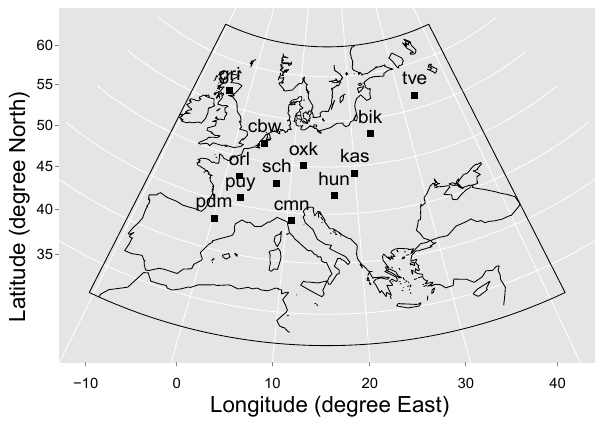
Fig. 1. Spatial domain of the WRF-VPRM simulations. Squares indicate the location of continuous CO 2 measurement sites. The model grid cells containing these stations were used for point com-